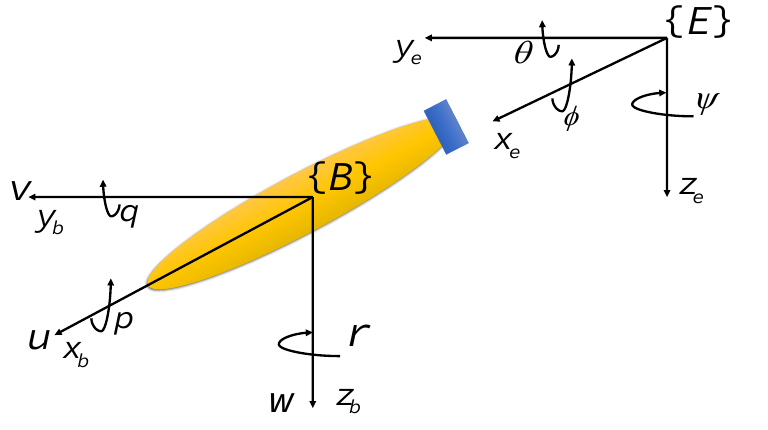
Figure 1. AUV model in